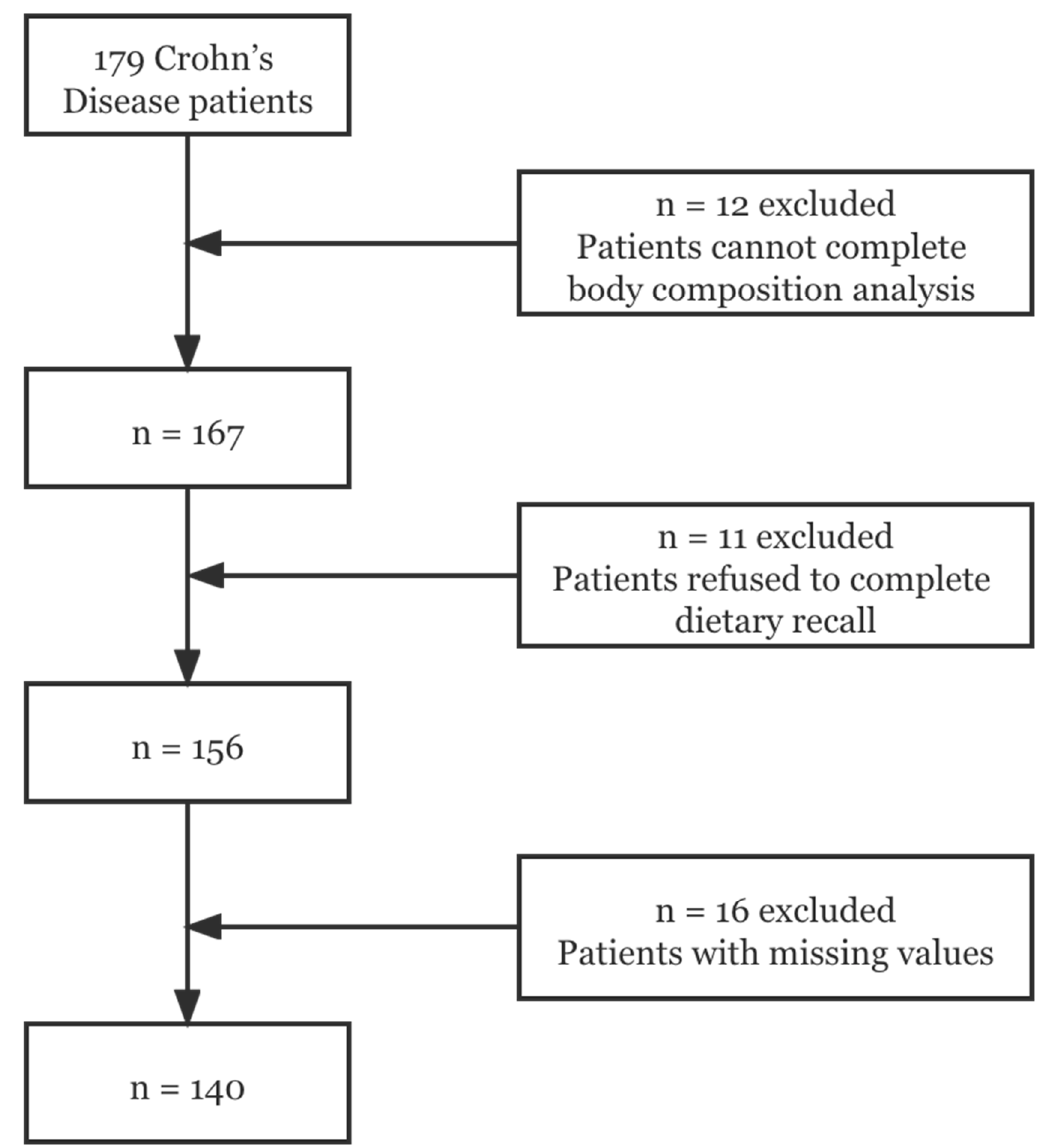
Figure 1. Flow chart of participants.